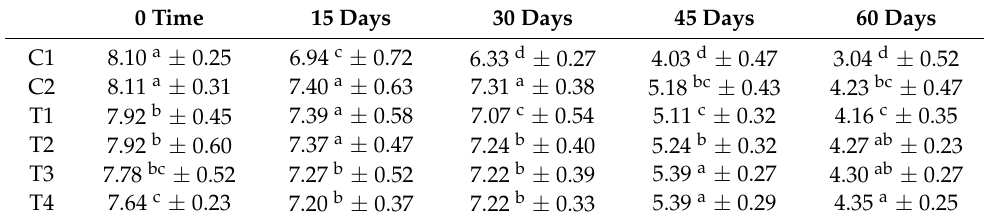
Table 12. Means of overall acceptability values of mayonnaise samples enriched with RCFE during storage.